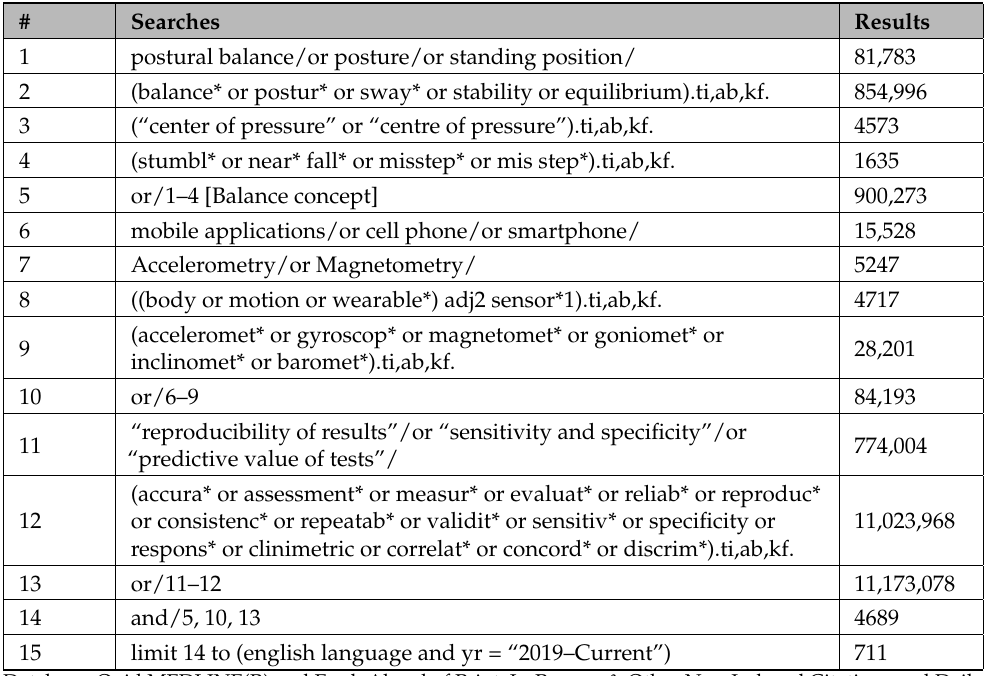
Table A1. Search strategy for Ovid